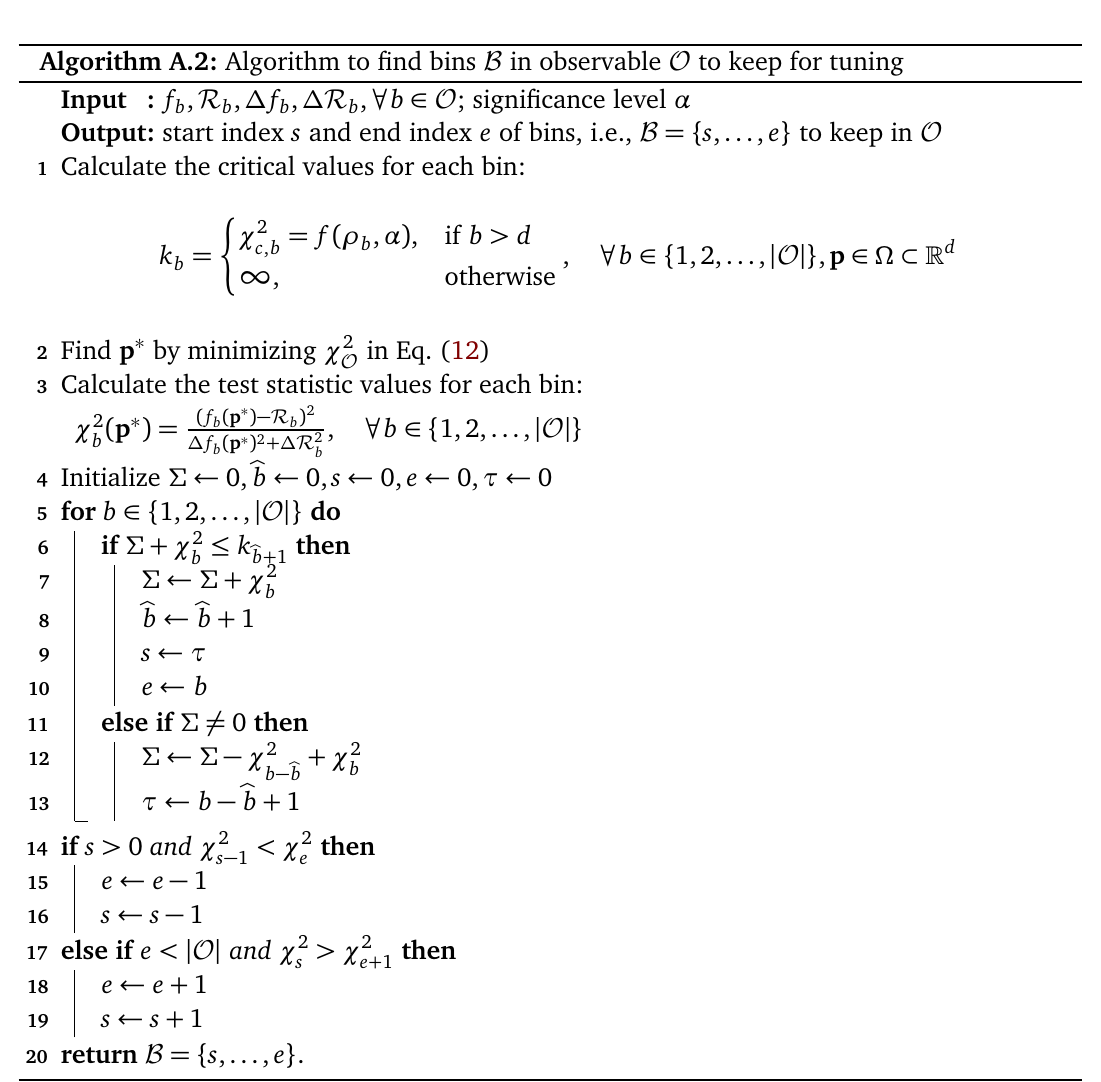
in observable to keep for tuning B O